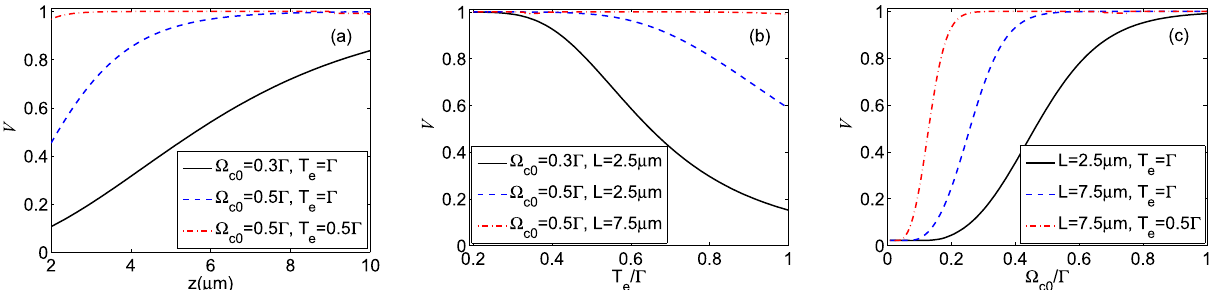
Figure 8. The visibility of the intensity profile of the quarter Talbot plane as a function of ( a ) medium length (for � c 0 = 0.3 Ŵ and T e = Ŵ (solid curve), � c 0 = 0.5 Ŵ and T e = Ŵ (dashed curve), and � c 0 = 0.5 Ŵ and T e = 0.5 Ŵ (dash-dotted curve)), ( b ) tunneling parameter (for � c 0 = 0.3 Ŵ and L = 2.5 µ m (solid curve), � c 0 = 0.5 Ŵ and L = 2.5 µ m (dashed curve), and � c 0 = 0.5 Ŵ and L = 7.5 µ m (dash-dotted curve)), and ( c ) strength of the coupling field (for L = 2.5 µ m and T e = Ŵ (solid curve), L = 7.5 µ m and T e = Ŵ (dashed curve), and L = 7.5 µ m and T e = 0.5 Ŵ (dash-dotted curve)). Other used parameters are the same as in Fig.